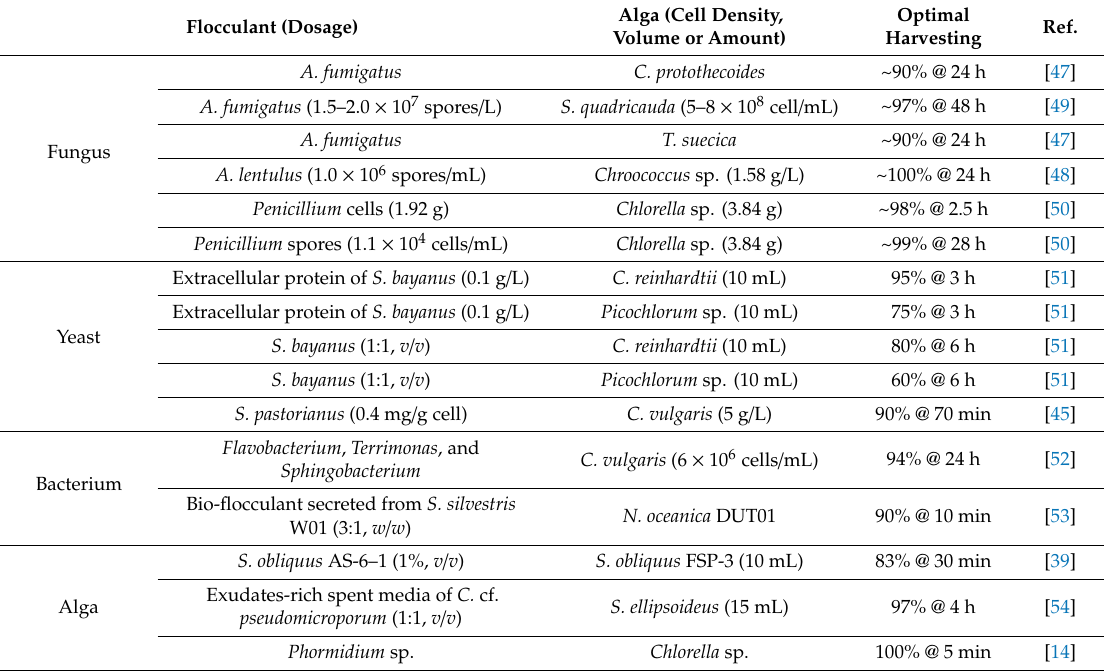
Table 2. Comparison of bio-flocculation techniques for algae